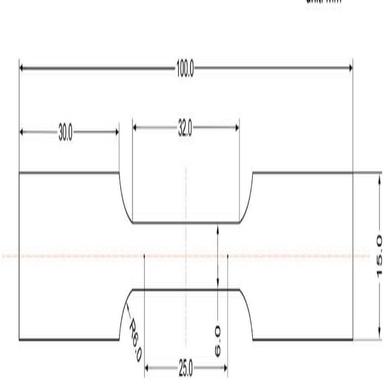
Geometry of tensile samples.